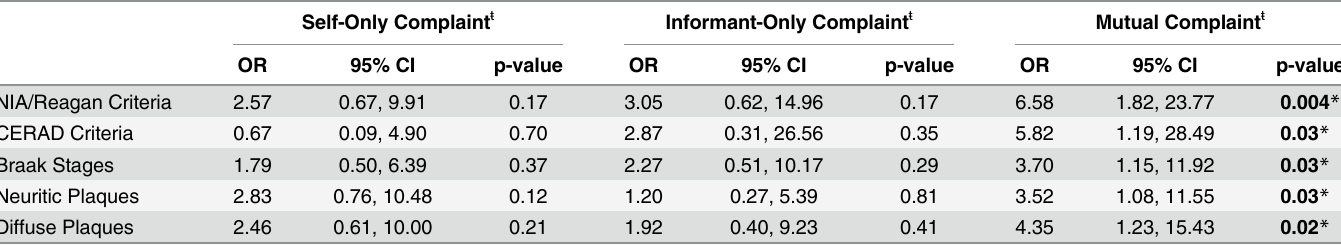
Table 2. Odds Ratios for Neuropathology Outcomes in